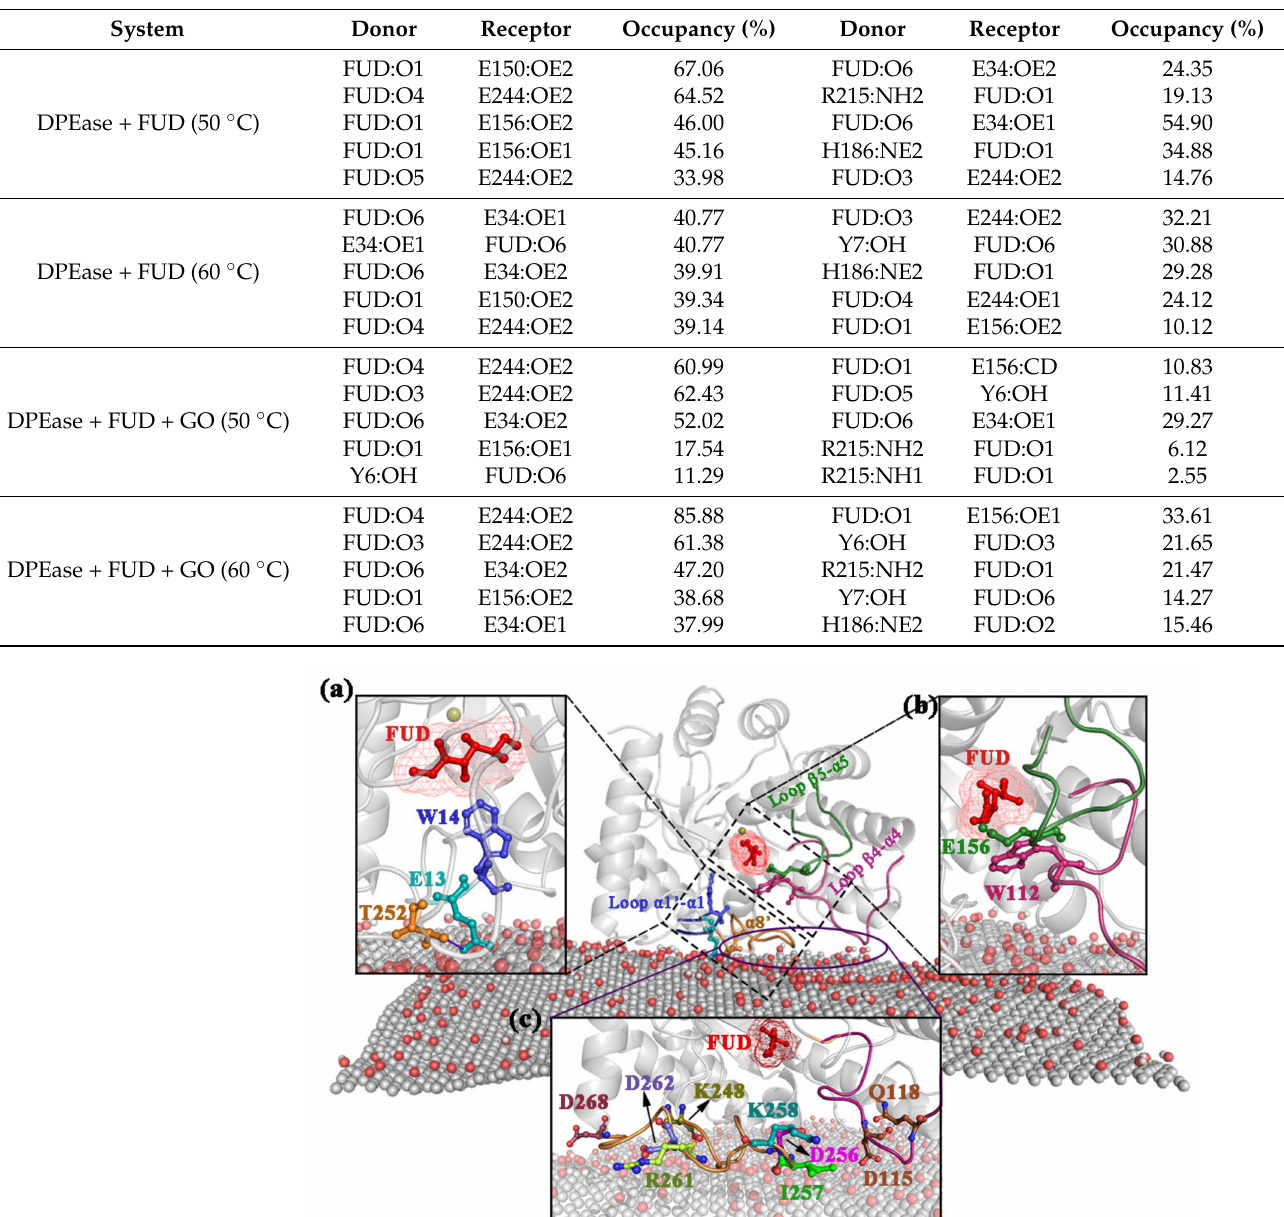
Table 2. Hydrogen bond occupancies between protein (DPEase) and ligand (FUD) for four systems during 300 ns MD simulations.